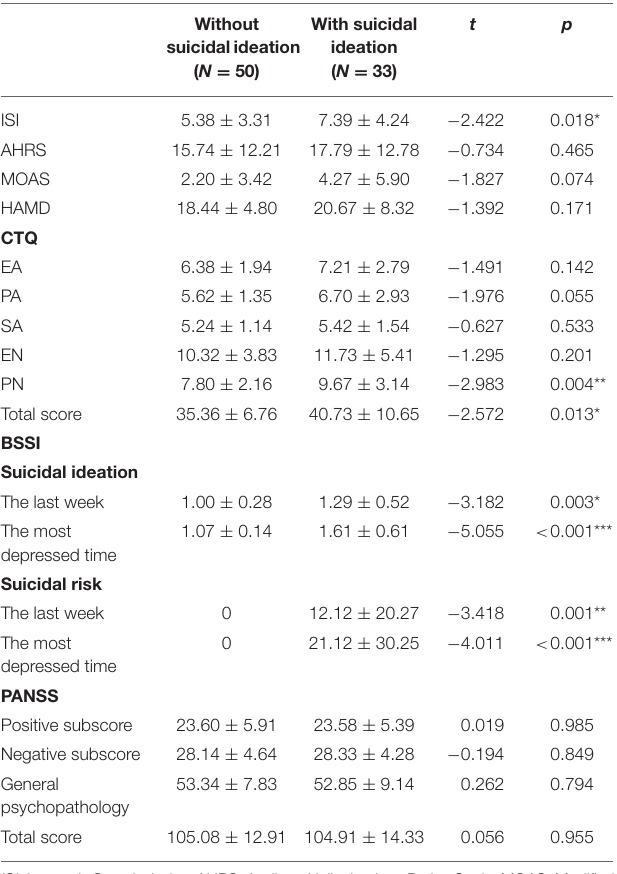
TABLE 2 | Comparisons between schizophrenic patients with and without suicidal ideation. Without suicidalideation